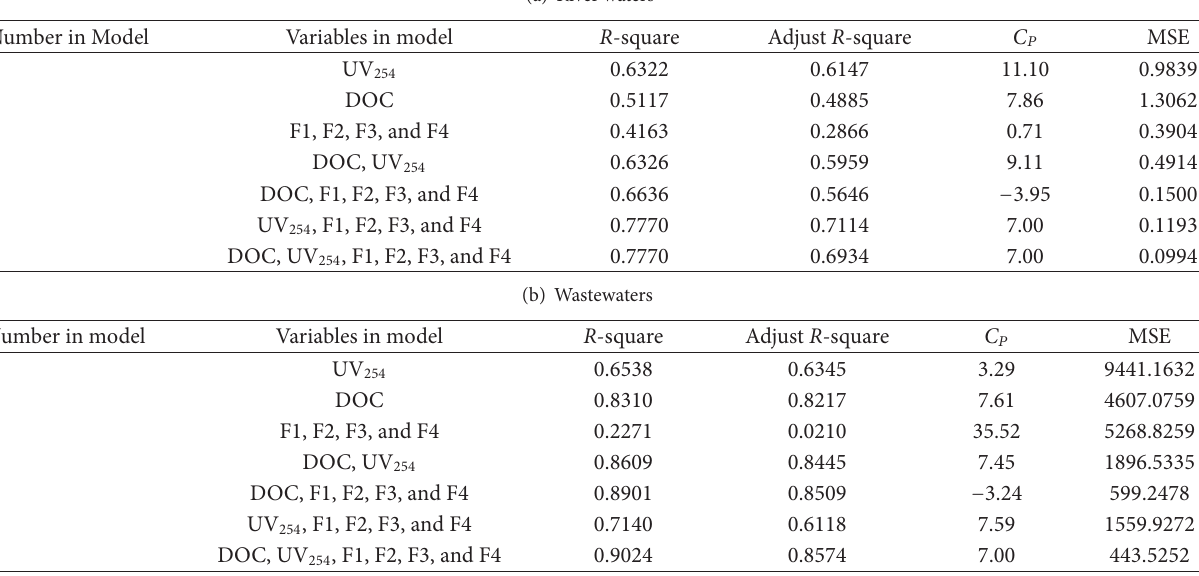
T 3: Summary of model development for predicting BOD 5 of (a) river waters and (b) wastewaters.